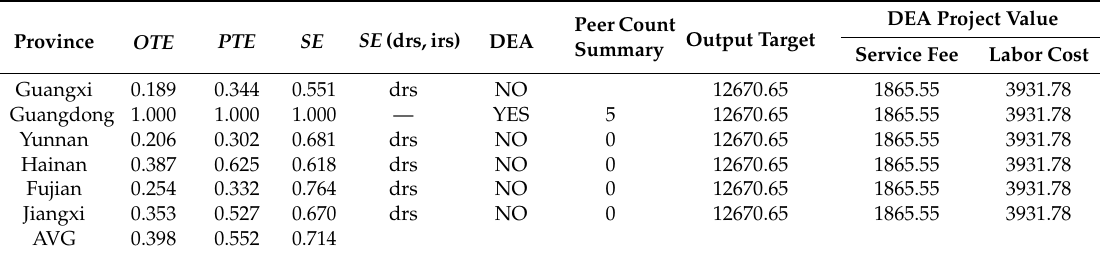
Table 5. Six province cassava production efficiency (DEA) in